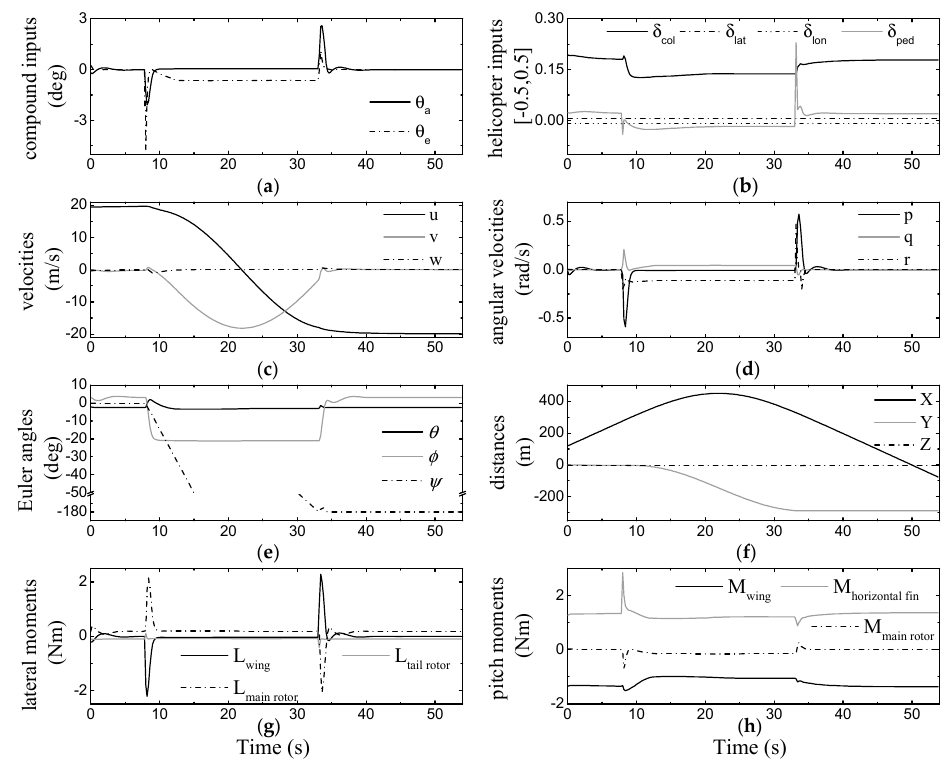
Figure 14. Simulation results in coordinated turn under Configuration WDH. ( a ) Compound inputs; ( b ) Helicopter inputs; ( c ) Velocities; ( d ) Angular velocities; ( e ) Euler angles; ( f ) Distances; ( g ) Lateral moments; ( h ) Pitch moments.